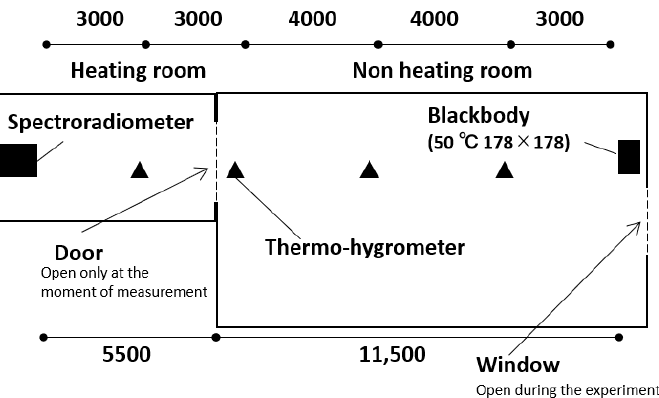
Figure 2. Overview of the indoor experiment. The dimensions are indicated in millimeters.